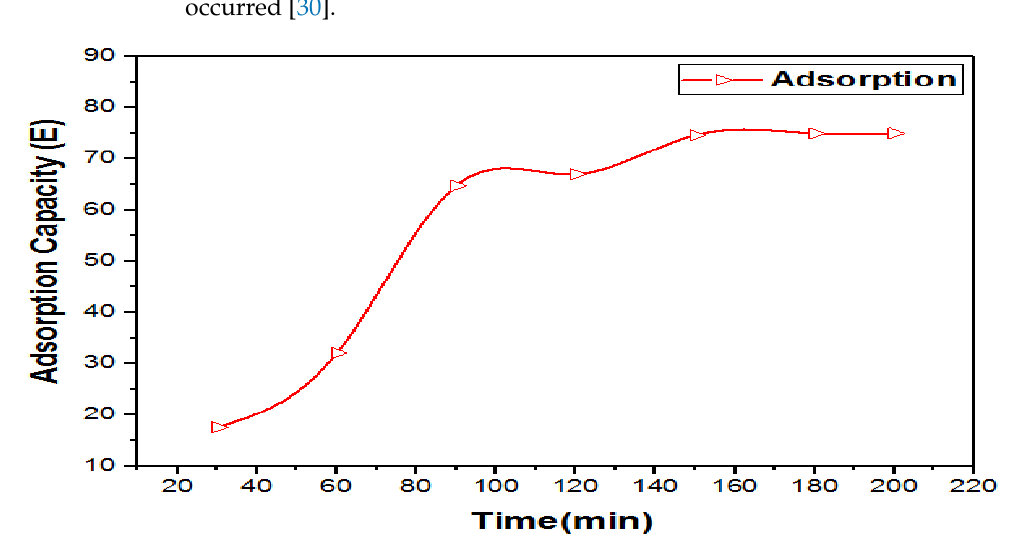
Figure 16. Effect of contact time on the adsorption process.